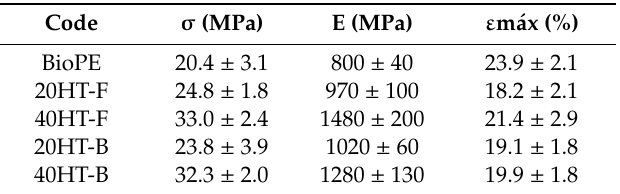
Table 2. Tensile strength ( σ ), Young (cid:48) s modulus (E), and elongation at maximum strength ( ε m á x) of